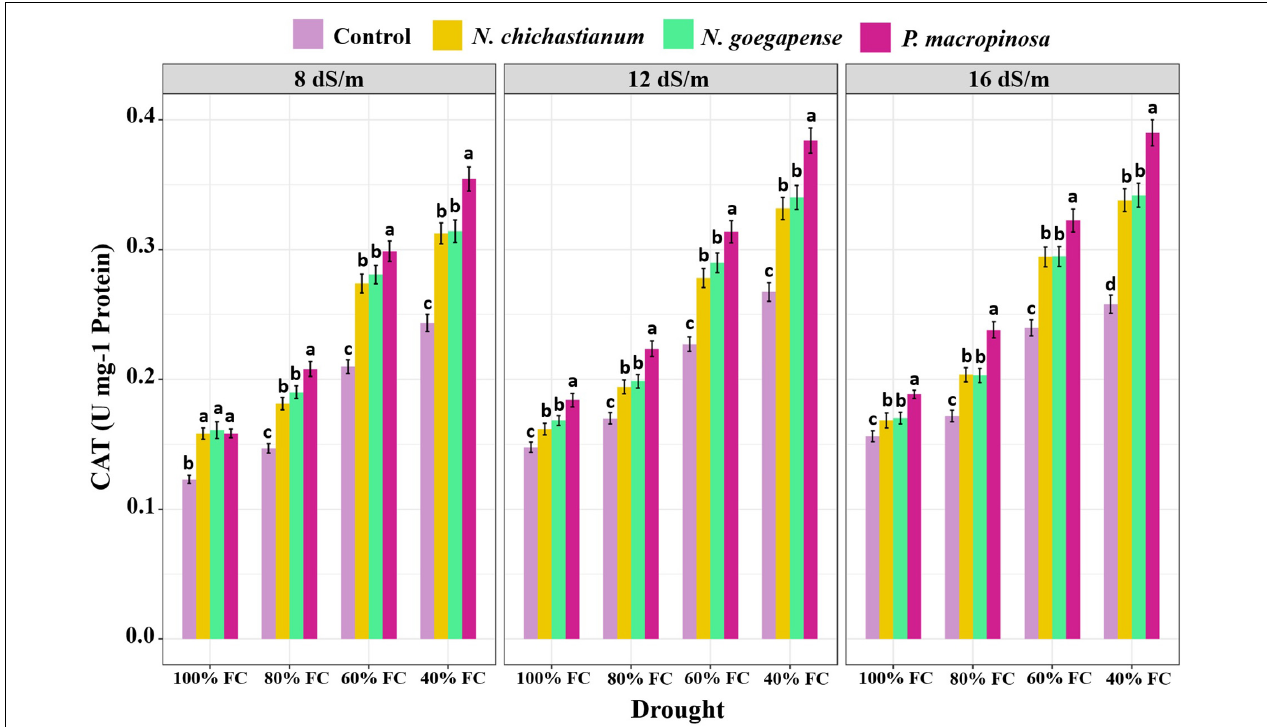
FIGURE 4 | The effects of halotolerant endophytic fungi species on CAT activity of barley plants, under salinity and drought stress. Different levels of drought stress and different fungal treatment are shown on the horizontal axis and colorful bars, respectively. Various letters on the top of bars display significant differences between mean values of different fungal treatments under the different levels of salinity and drought stress at p ≤